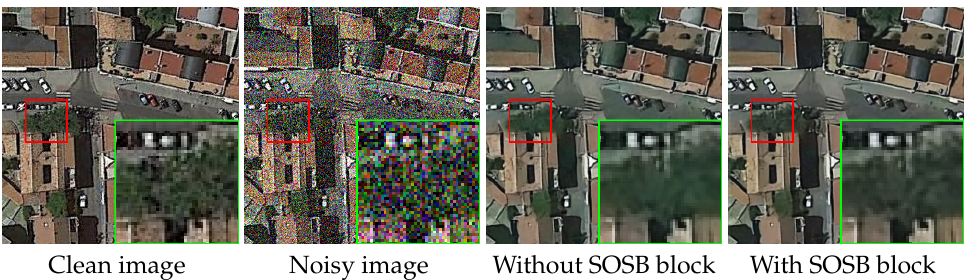
Figure 21. Enlarged detail comparisons of with/without SOSB block modules (with white Gaussian noise level σ 2 =